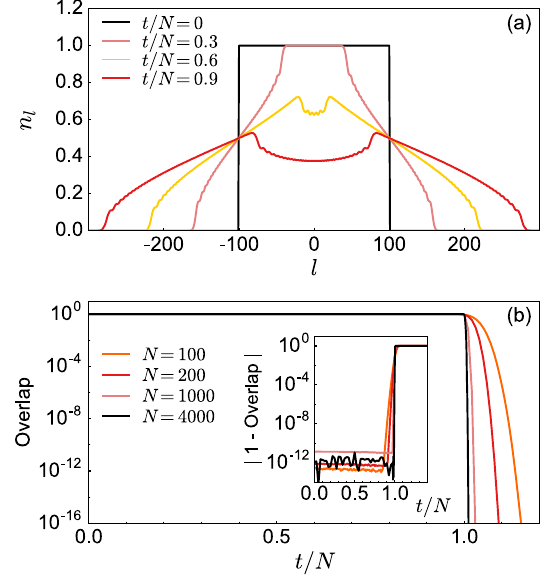
FIG. 5. Sudden expansion of noninteracting spinless fermions, or hard-core bosons, in optical lattices. (a) Site occupations n t Þ ¼ h ψ ð t Þj ˆ n ψ ð t Þi at different times. (b) Overlap O ð t Þ ¼ l ð l j jh Ψ t j ψ ð t Þij between the time-evolving state j ψ ð t Þi and the eigenstate j Ψ t i of the emergent local Hamiltonian in Eq. (39), and j 1 − O ð t Þj in the inset. The results are plotted versus the rescaled time t=N for four system sizes. When increasing the number of particles N , O ð t Þ ¼ 1 within machine precision (see inset) until t=N ≈ 1